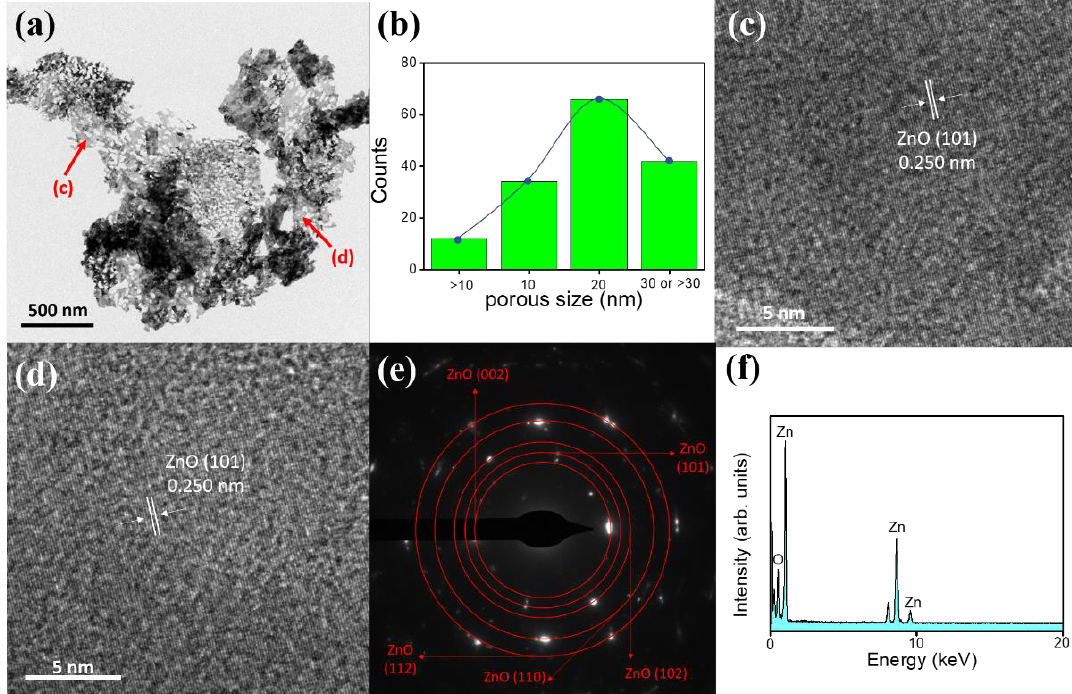
Figure 4. TEM analysis of the ZnO-H sheet: ( a ) low-magnification image. ( b ) Histogram of pore size. ( c , d ) HRTEM images. ( e ) SAED pattern. ( f ) EDS spectrum.